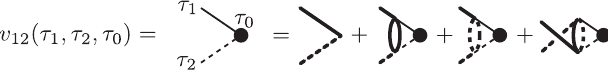
FIG. 7. The Bethe-Salpeter equations for the three-point functions v 12